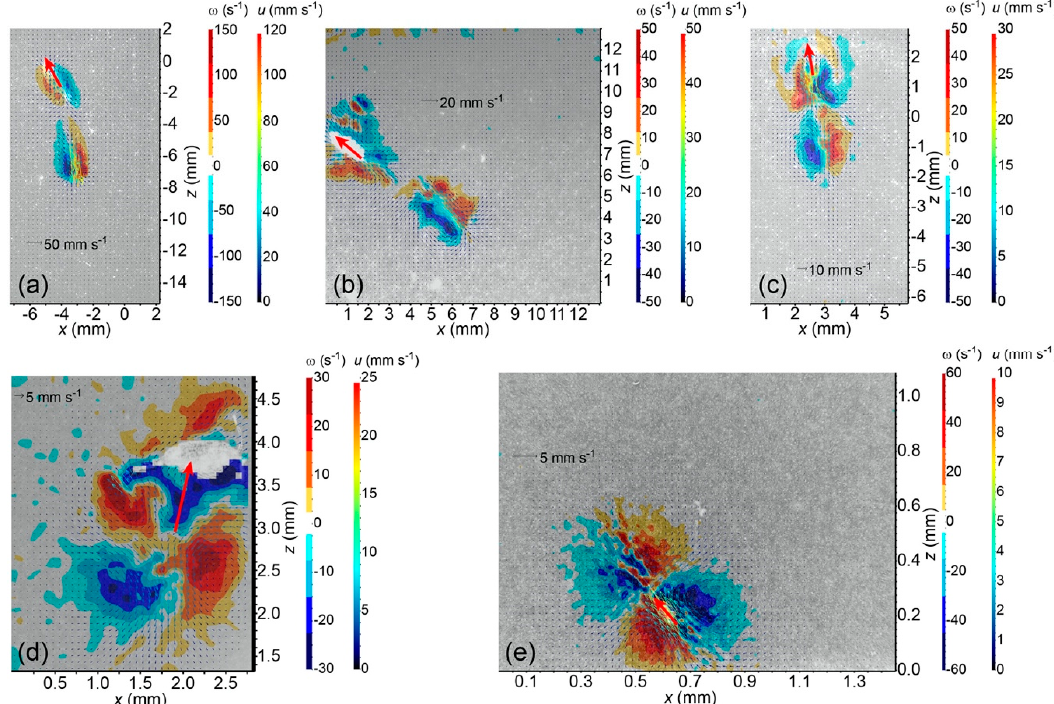
Figure 1. Time-resolved PIV measurements of jump-imposed instantaneous flow velocity vector and vorticity fields by ( a ) a squid Doryteuthis pealeii paralarva, ( b ) a copepod Calanus finmarchicus , ( c ) a small medusa Sarsia tubulosa (PIV data were obtained by [16]), ( d ) a copepod Acartia hudsonica female, and ( e ) a ciliate Pseudotontonia sp. (PIV data were obtained by [18]). The filled color contours are vorticity fields. The velocity vectors are colored by flow velocity magnitudes. In each panel, the solid red arrow indicates the jumping direction of the body. Details of the events are presented by Supplementary Video Group S1.